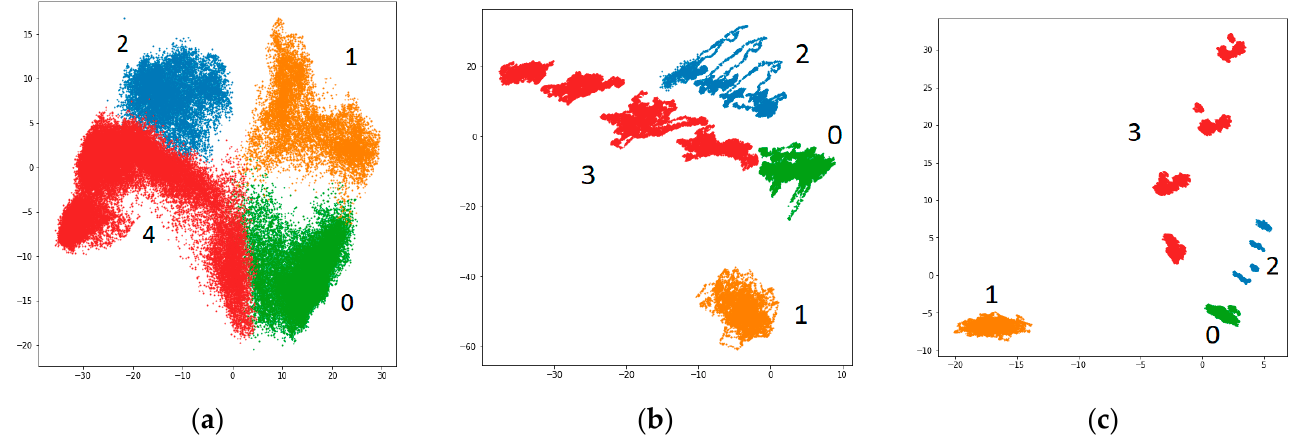
Figure 8. Embeddings of 4 system states with the experimental data generated by the model trained on a mixed dataset for different window sizes: ( a ) 1 s; ( b ) 10 s; ( c ) 50 s. System states legend: green (0)—a “healthy” system; orange (1)—the HPA leak; blue (2)—the fluid leak; red (3)—the valve set error.